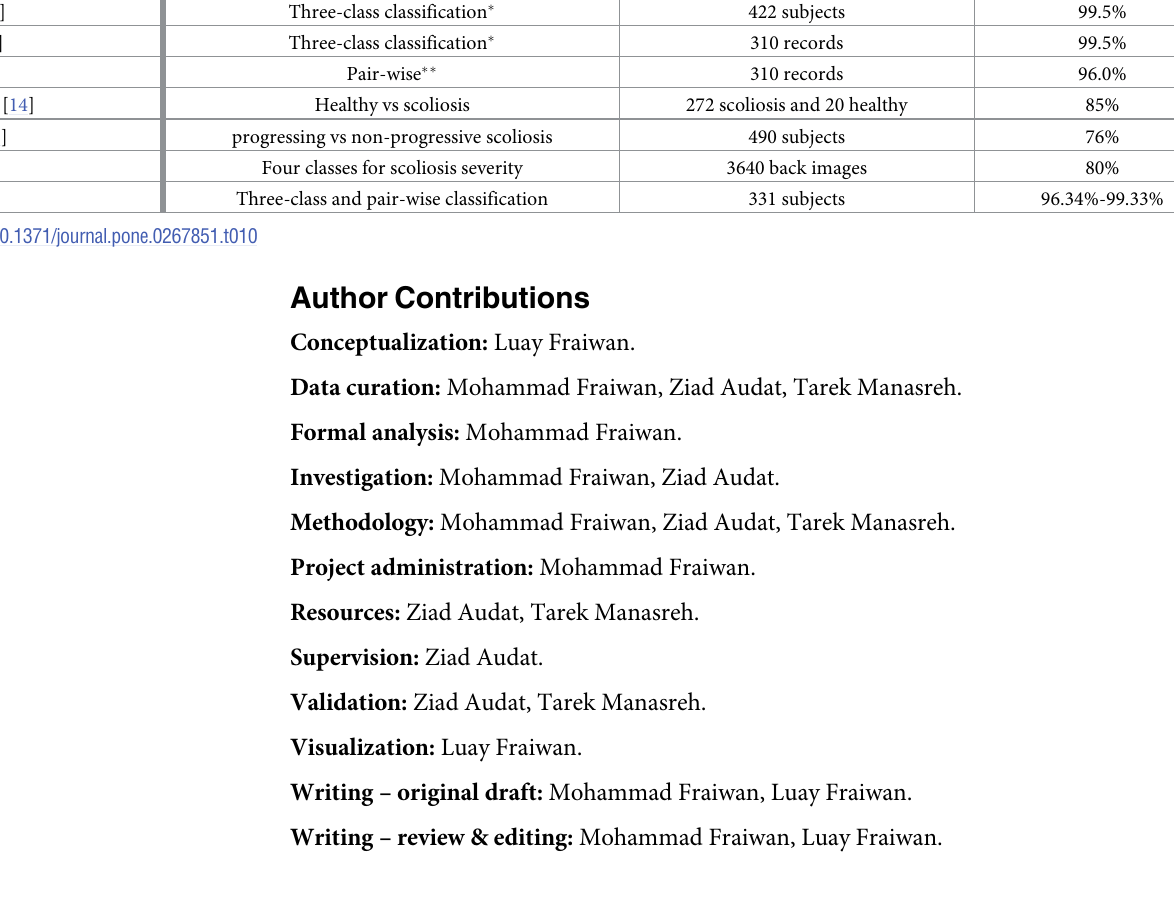
Table 10. Comparison to the related work in the literature. � healthy, disk herniation, or spondylolisthesis. �� Pair-wise permutation of healthy, disk herniation, and spondylolisthesis.